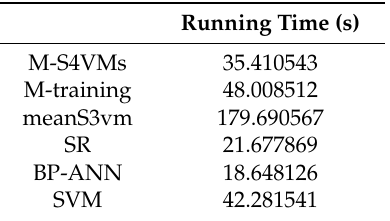
Table 12. Running time of classification rate of target gases per